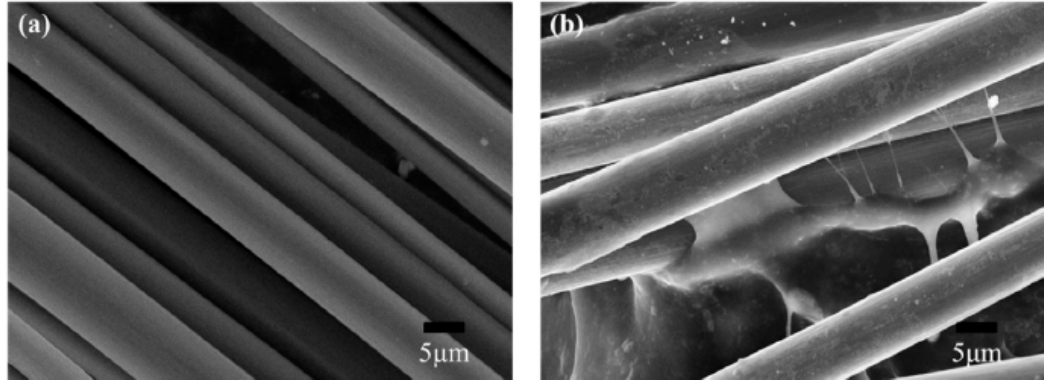
Figure 11. Morphologies of ( a ) un-treated carbon fibers (CFs) and ( b ) pre-oxidized treated CFs [69]. Reprinted with permission from [69]; 2018 Elsevier.